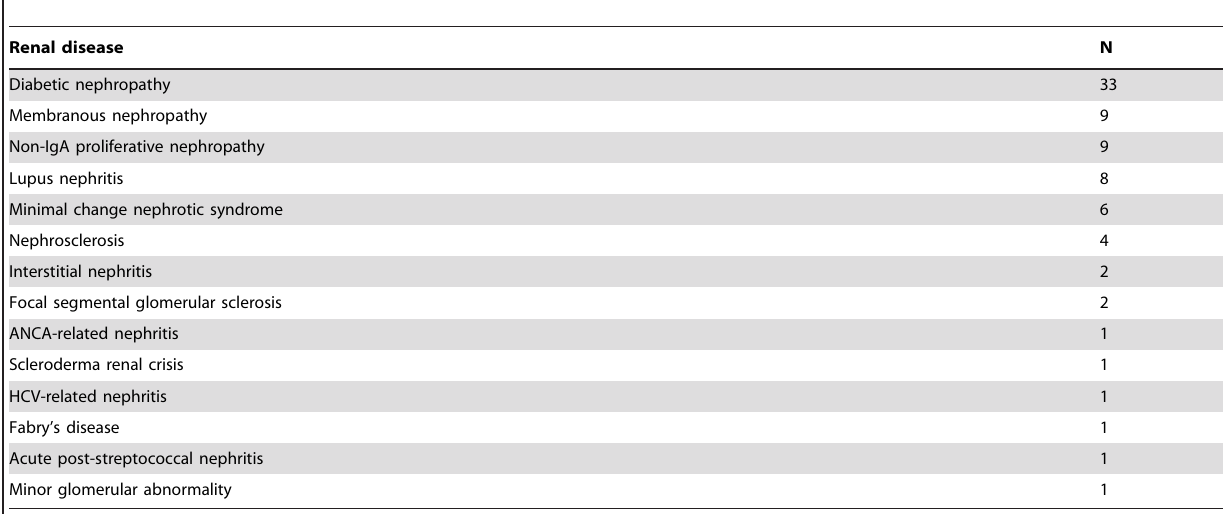
Table 1. Renal diseases in chronic kidney disease (CKD)